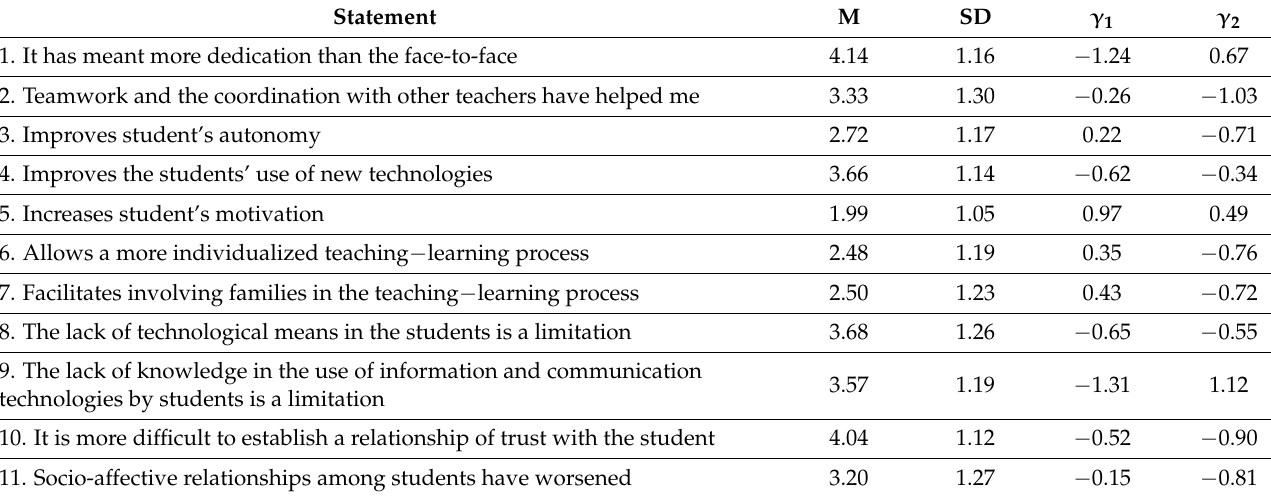
Table 1. Average degree of teachers’ agreement with the following statements, regarding teaching–learning in the blended model compared to fully face-to-face model (1 = Strongly disagree; 5 = Strongly agree).